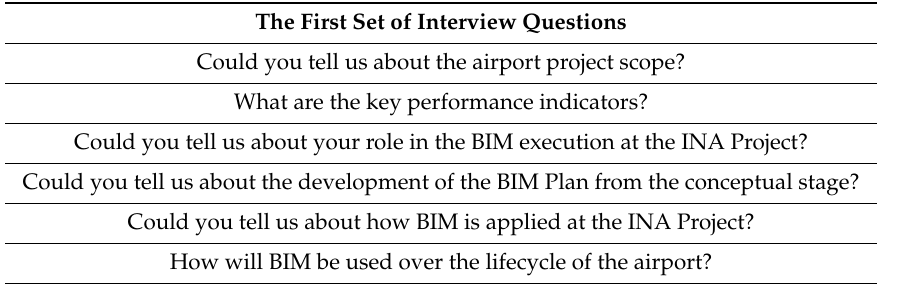
Table 3. The first set of interview questions.